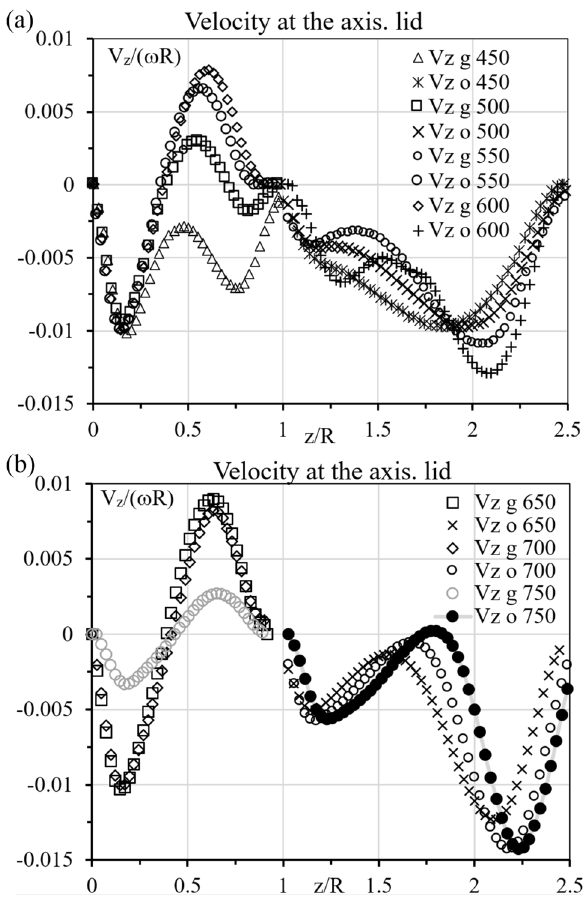
Figure 3. Symbols show the distribution of velocity at the axis in the glycerol (g) and oil (o). Numbers show values of Re, 450-600 ( a ), 650-750 ( b ). The ranges, V z < 0 and V z > 0, correspond to the centrifugal and anti- centrifugal circulations,